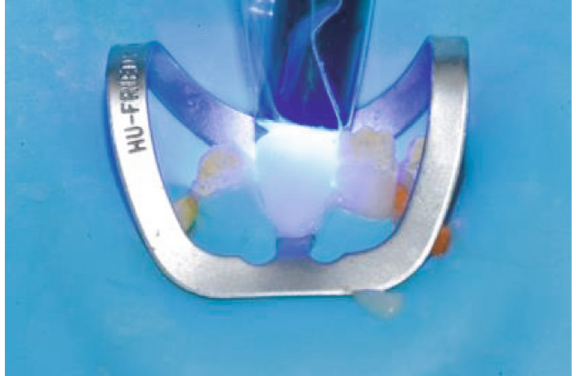
Figure 13: Veneer light cured on the